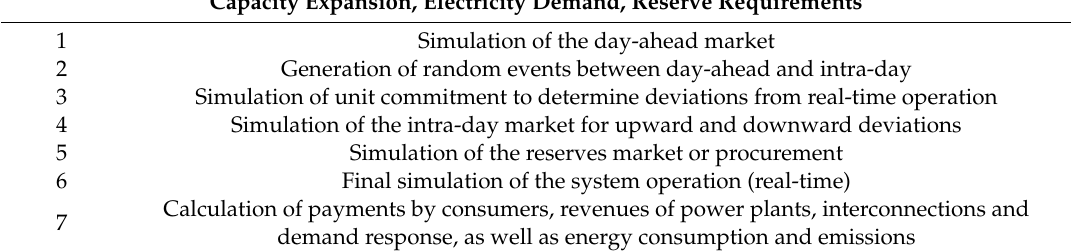
Table 1. Steps of the PRIMES-IEM modelling approach, performing market simulation for the entire EU interconnected system.